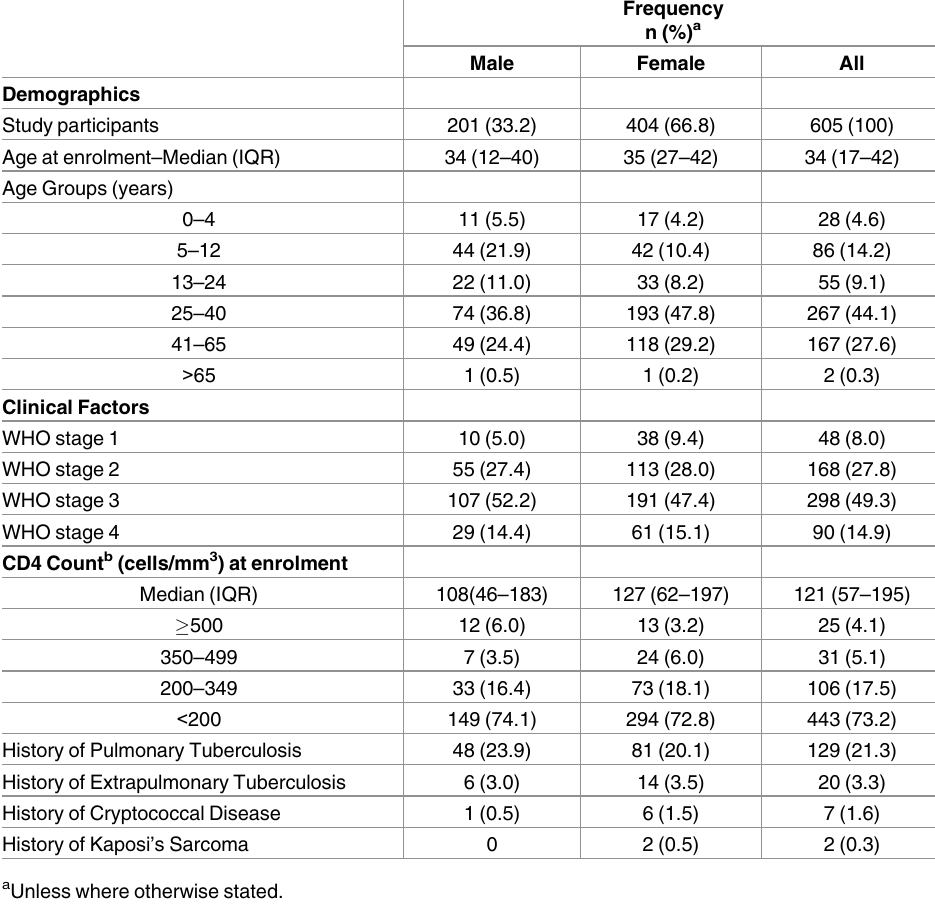
Table 1. Baseline demographic and clinical characteristics (N =